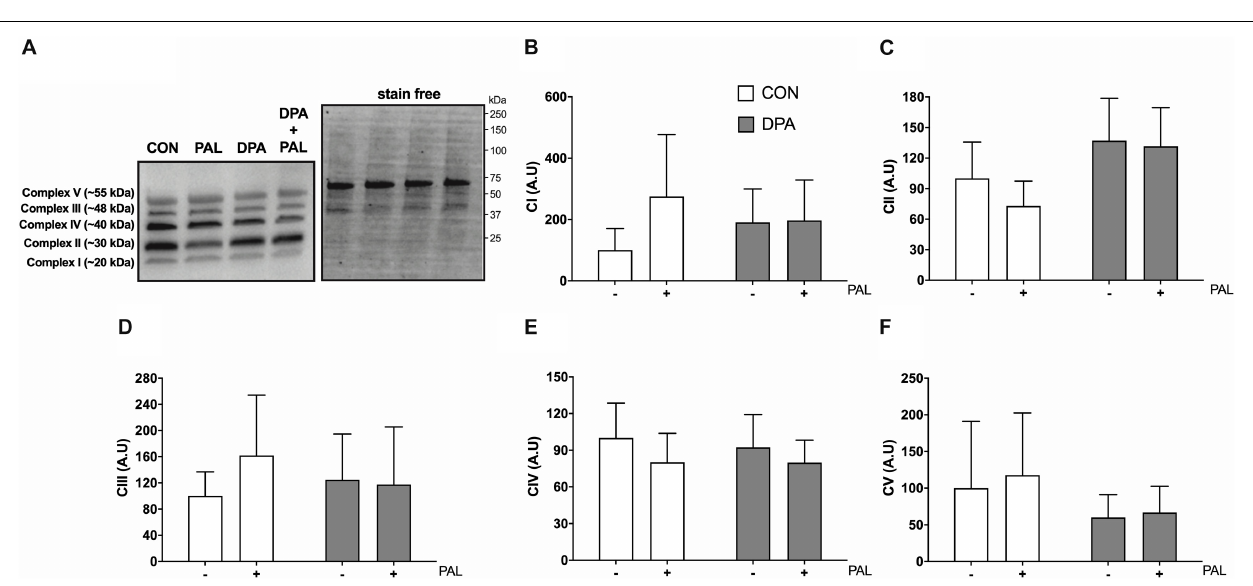
FIGURE 6 | Treatment with DPA and/or PAL does not alter myoblast mitochondrial content. Protein content of mitochondrial OXPHOS complexes following 16 h treatment with 500 µ M PAL and/or 50 µ M EPA, DPA, or DHA and representative images (A–F) . All densitometry values are expressed relative to protein content determined by stain free imaging ( A ; representative image shown with molecular weight markers indicated) and presented in arbitrary units relative to CON. Myoblasts were cultured and harvested independently to generate a total sample size of 6 biological replicates. Values are presented as mean ± SEM.